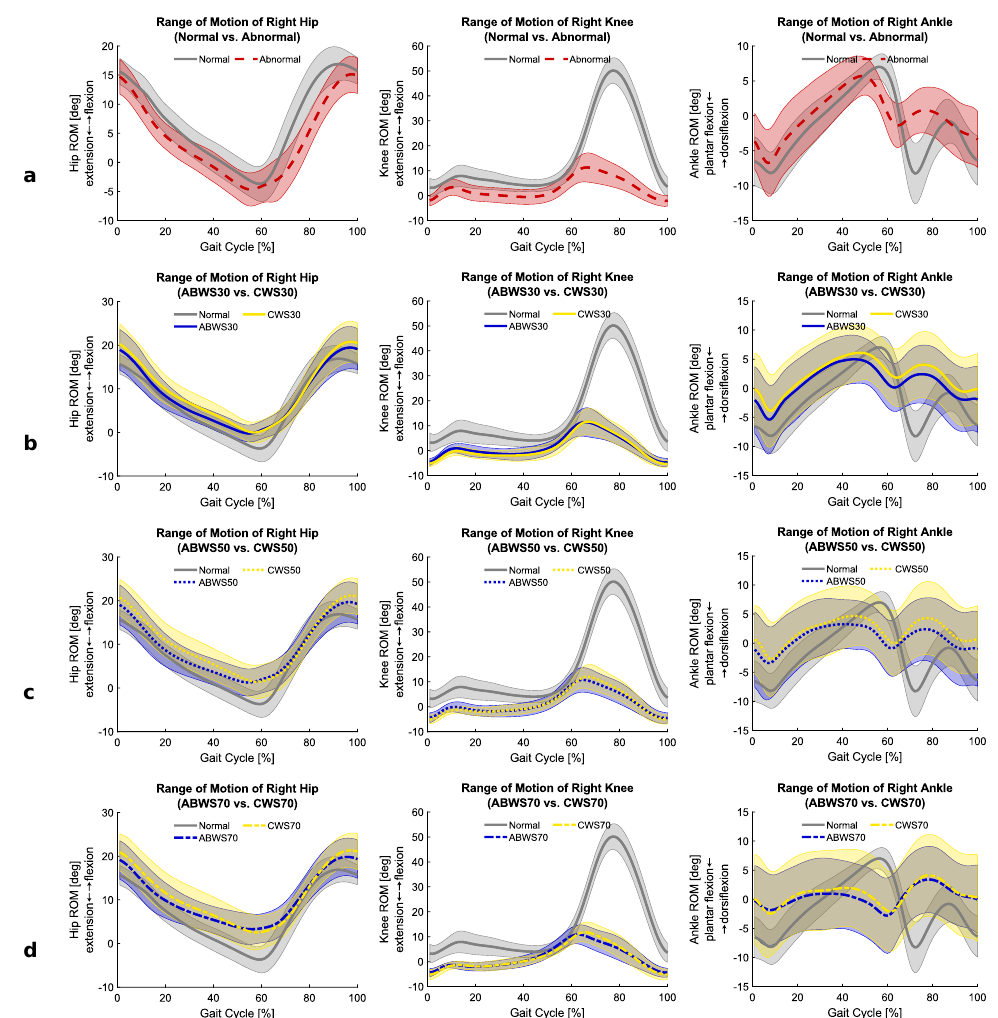
Figure 9. The comparison of the ROS of the hip, knee and ankle joint on the right side. ( a ) represents the comparison of the hip, knee and ankle joint movement between normal walking and abnormal walking. ( b – d ) represent the comparison of ROM of the abnormal walking under the ABWS and CW system at 30%, 50% and 70%,